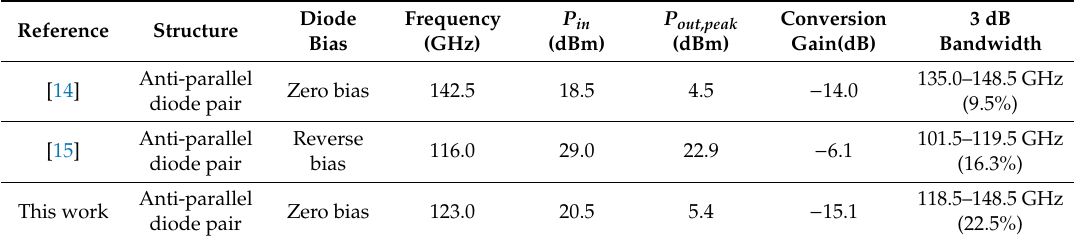
Table 3. Reported D-band frequency tripler modules using GaAs Schottky Table 3. Reported D ‐ band frequency tripler modules using GaAs Schottky diodes.